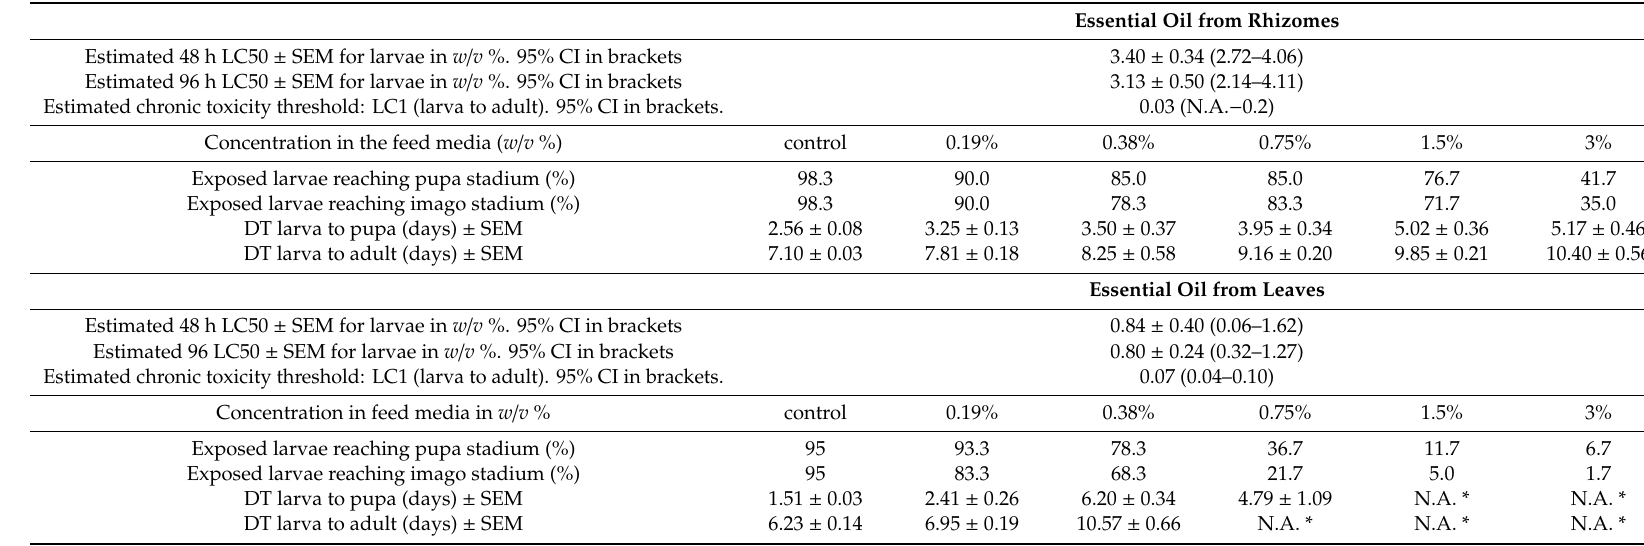
Table 5. E ff ects of essential oils of Petasites hybridus subsp. ochroleucus obtained from rhizomes and leaves on D. melanogaster survival.